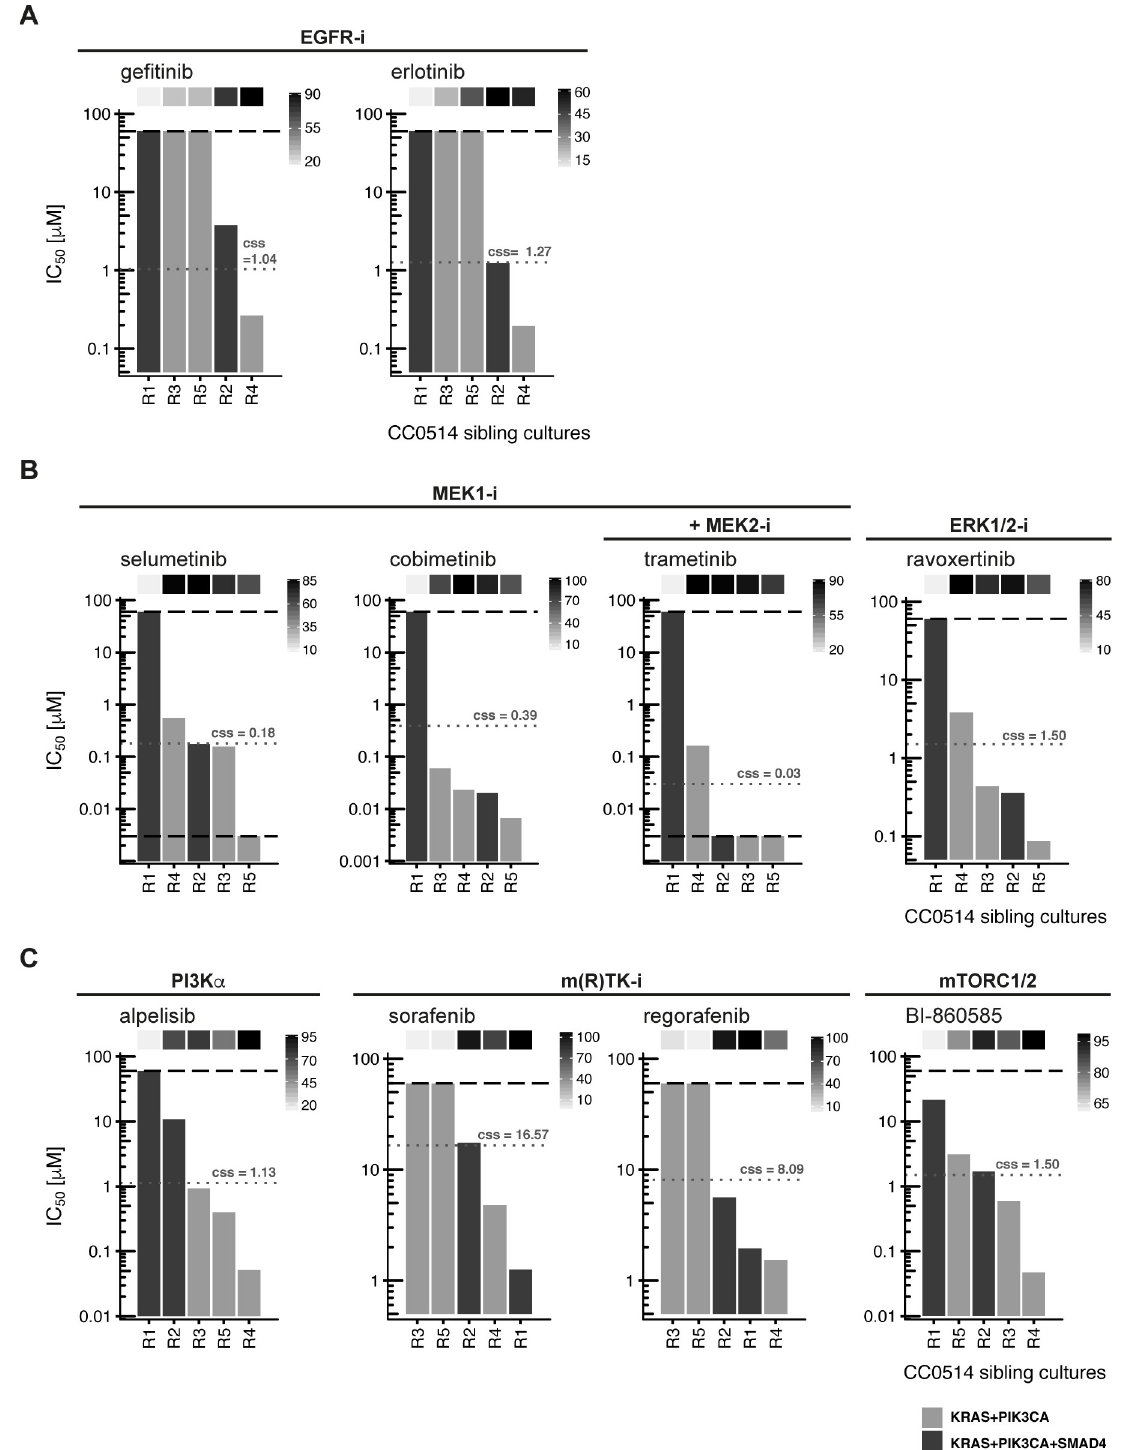
Fig 5. Organoid sibling cultures display heterogeneous drug responses. IC 50 values for sibling cultures derived from patient tumor CC0514 treated with a panel of small molecules targeting EGFR, MEK/ERK, PI3K α , mTORC1/2 and multiple kinases are shown. The lower and upper assay cutoffs were 0.003 μ M and 60 μ M. Drug efficacy (E max ) was included as additional parameter of response, indicated with light grey to black boxes above the waterfall plot according to percent efficacy. Critical mutations in each culture are depicted in light and dark grey bars according to the legend at the bottom of the figure. Achievable steady state in vivo plasma